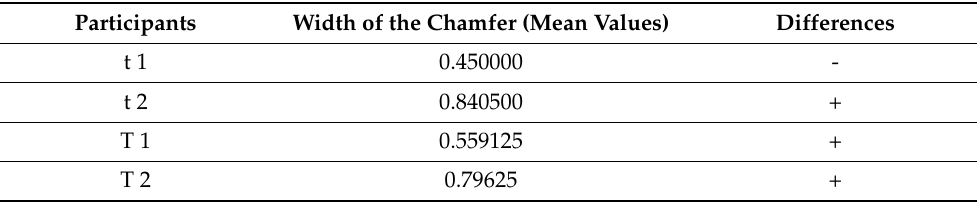
Table 2. Mean values of the width of the prepared